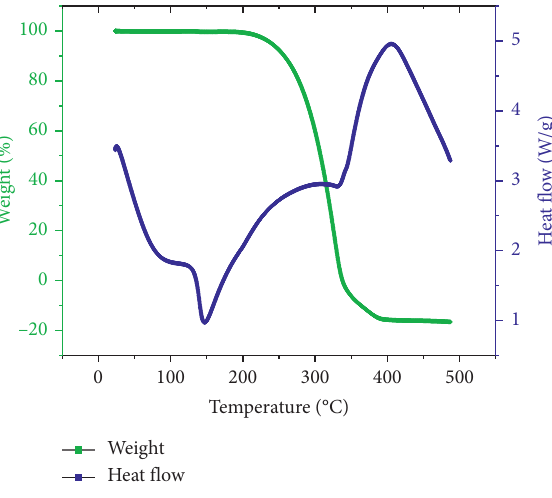
Figure 7: DSC and TGA thermogram of 3a. Table 9: DSC transition temperatures of phenolic ester